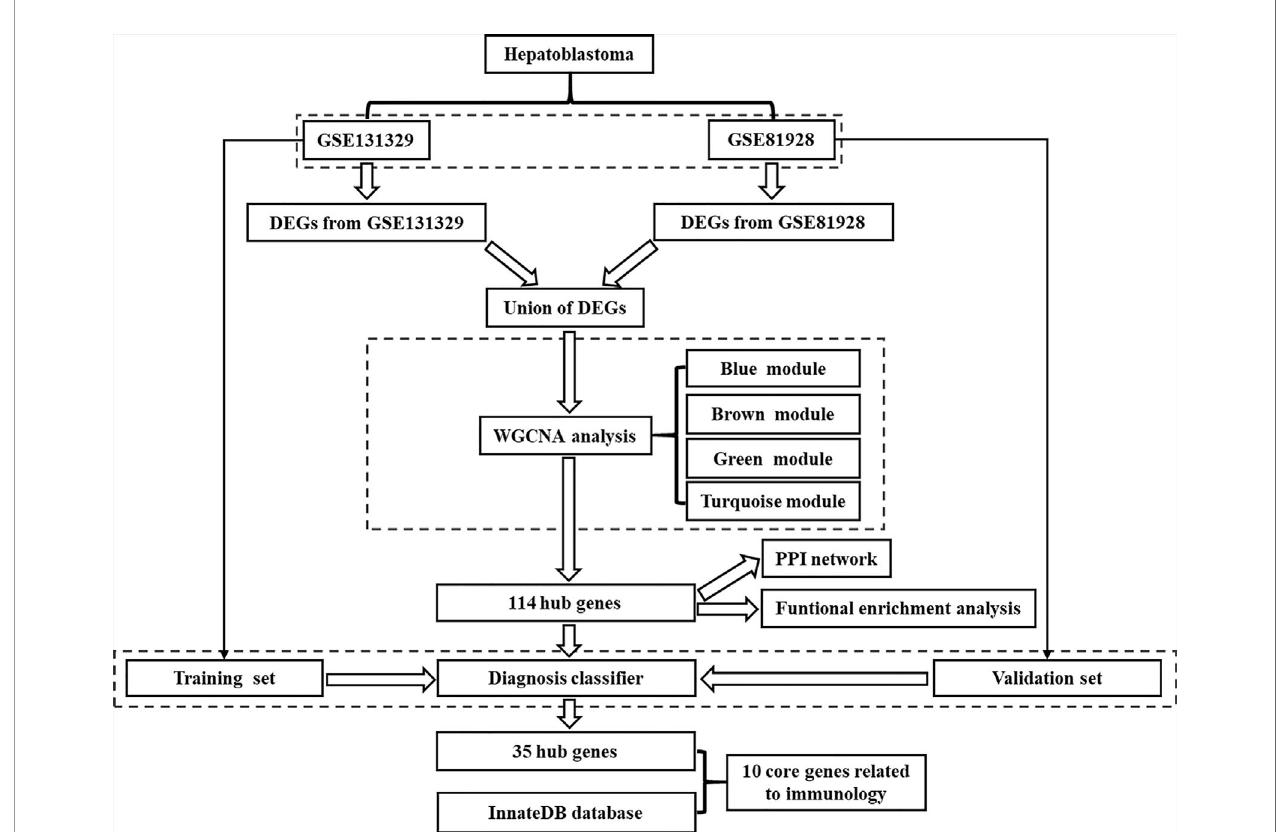
FIGURE 1 | Flowchart showing the protocol of the study. DEGs, differentially expressed genes; WGCNA, Weighted gene correlation network analysis; PPI, protein- protein